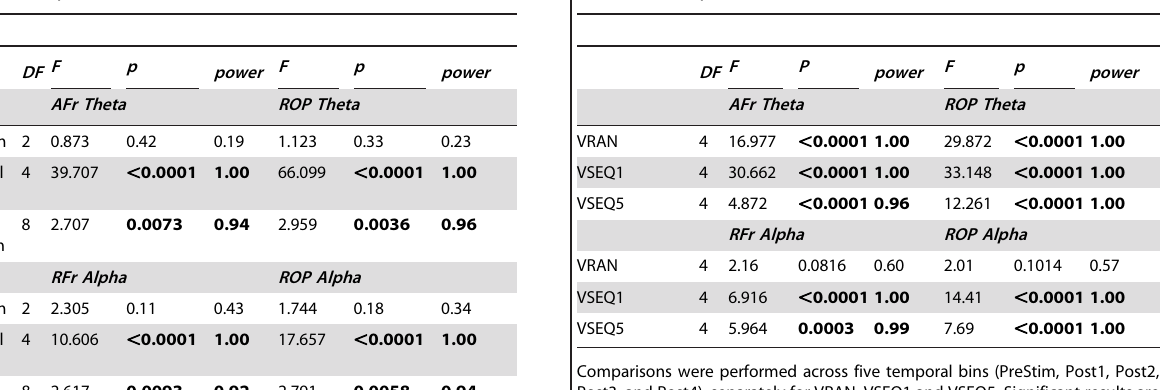
Table 1. Repeated measure ANOVAs in ROP (right occipito- parietal), AFr (Anterior Frontal) and RF (Right Frontal) areas for Theta and Alpha Bands.